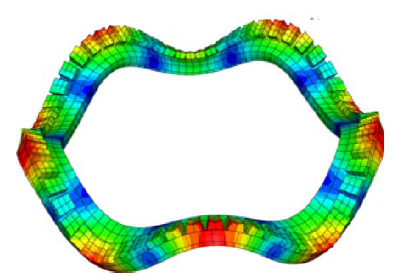
Figure 1. Snapshot on the transient response of a piezoelectric coupled ring with wave propagating (adopted from Figure 13d in